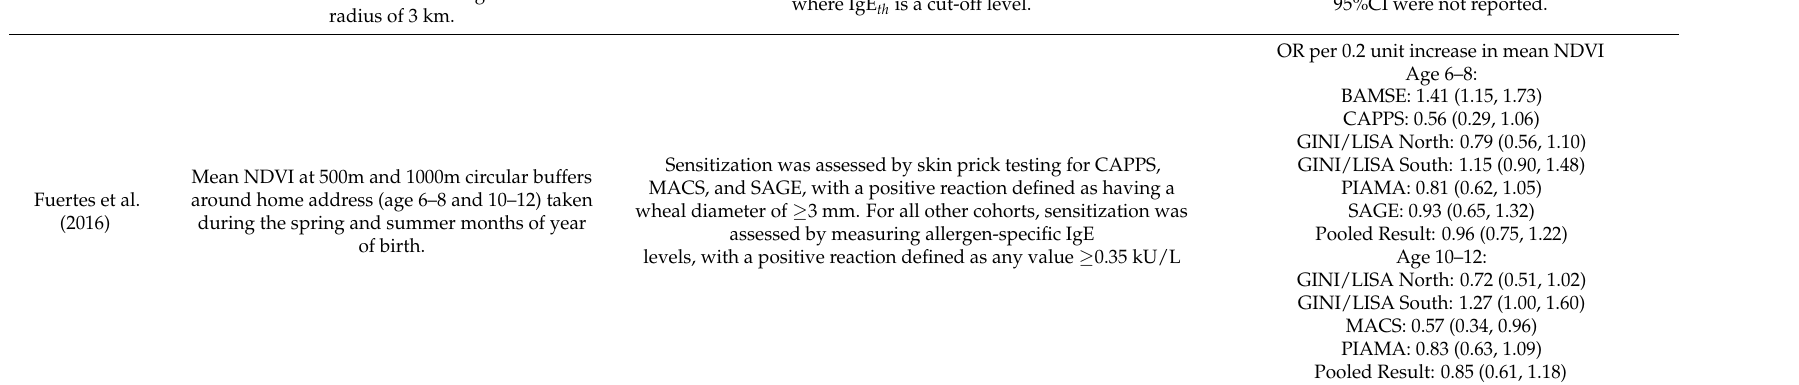
NDVI: Normalized Difference Vegetation Index; LiDAR: Light Detection and